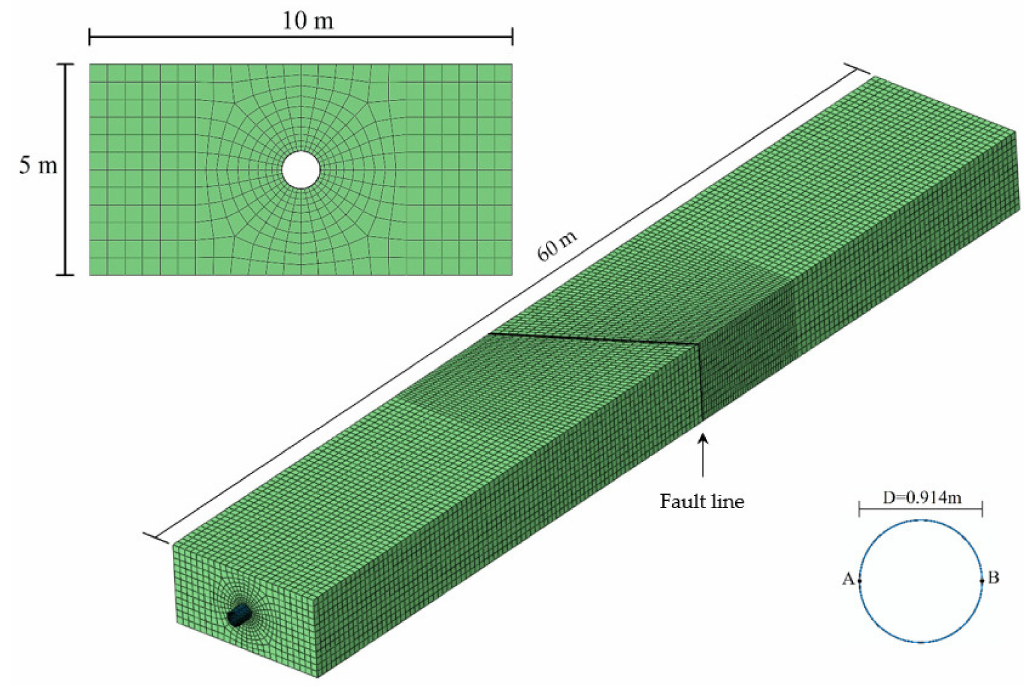
Figure 10. 3D solid model for a buried steel pipeline at a 60 ◦ strike-slip fault crossing. Points A and B are the springlines of the pipe. The fault displacement components were applied to the ends of the rigid elements at the end of the soil spring elements and the pipeline was free to move in the axial direction on both ends.